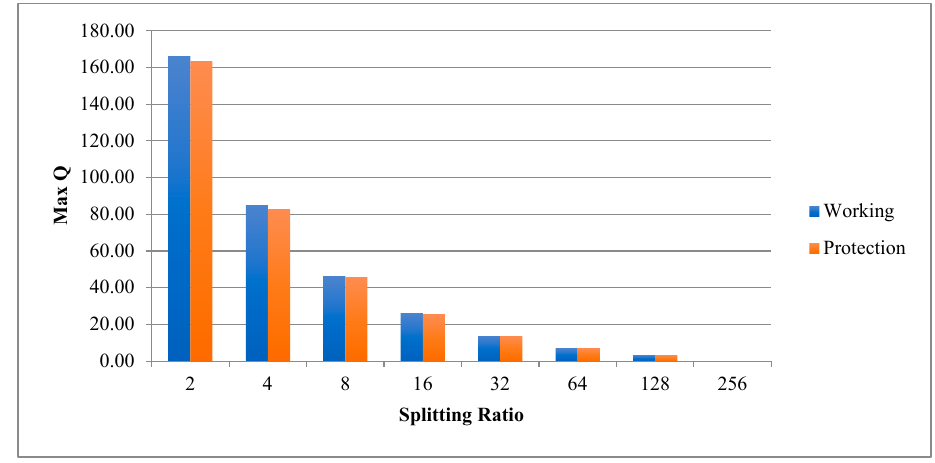
Figure 20. Maximum Q factor by varying the split ratio.